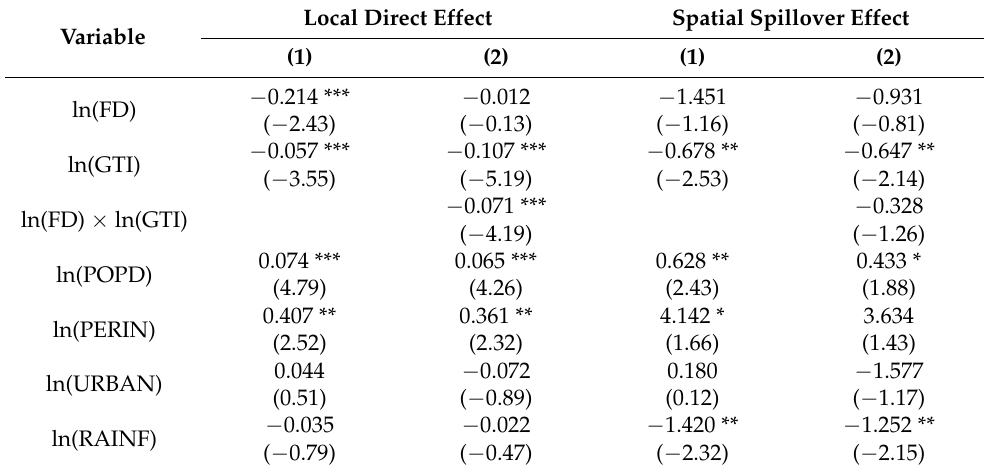
Table 7. Spatial measurement results based on economic geographic